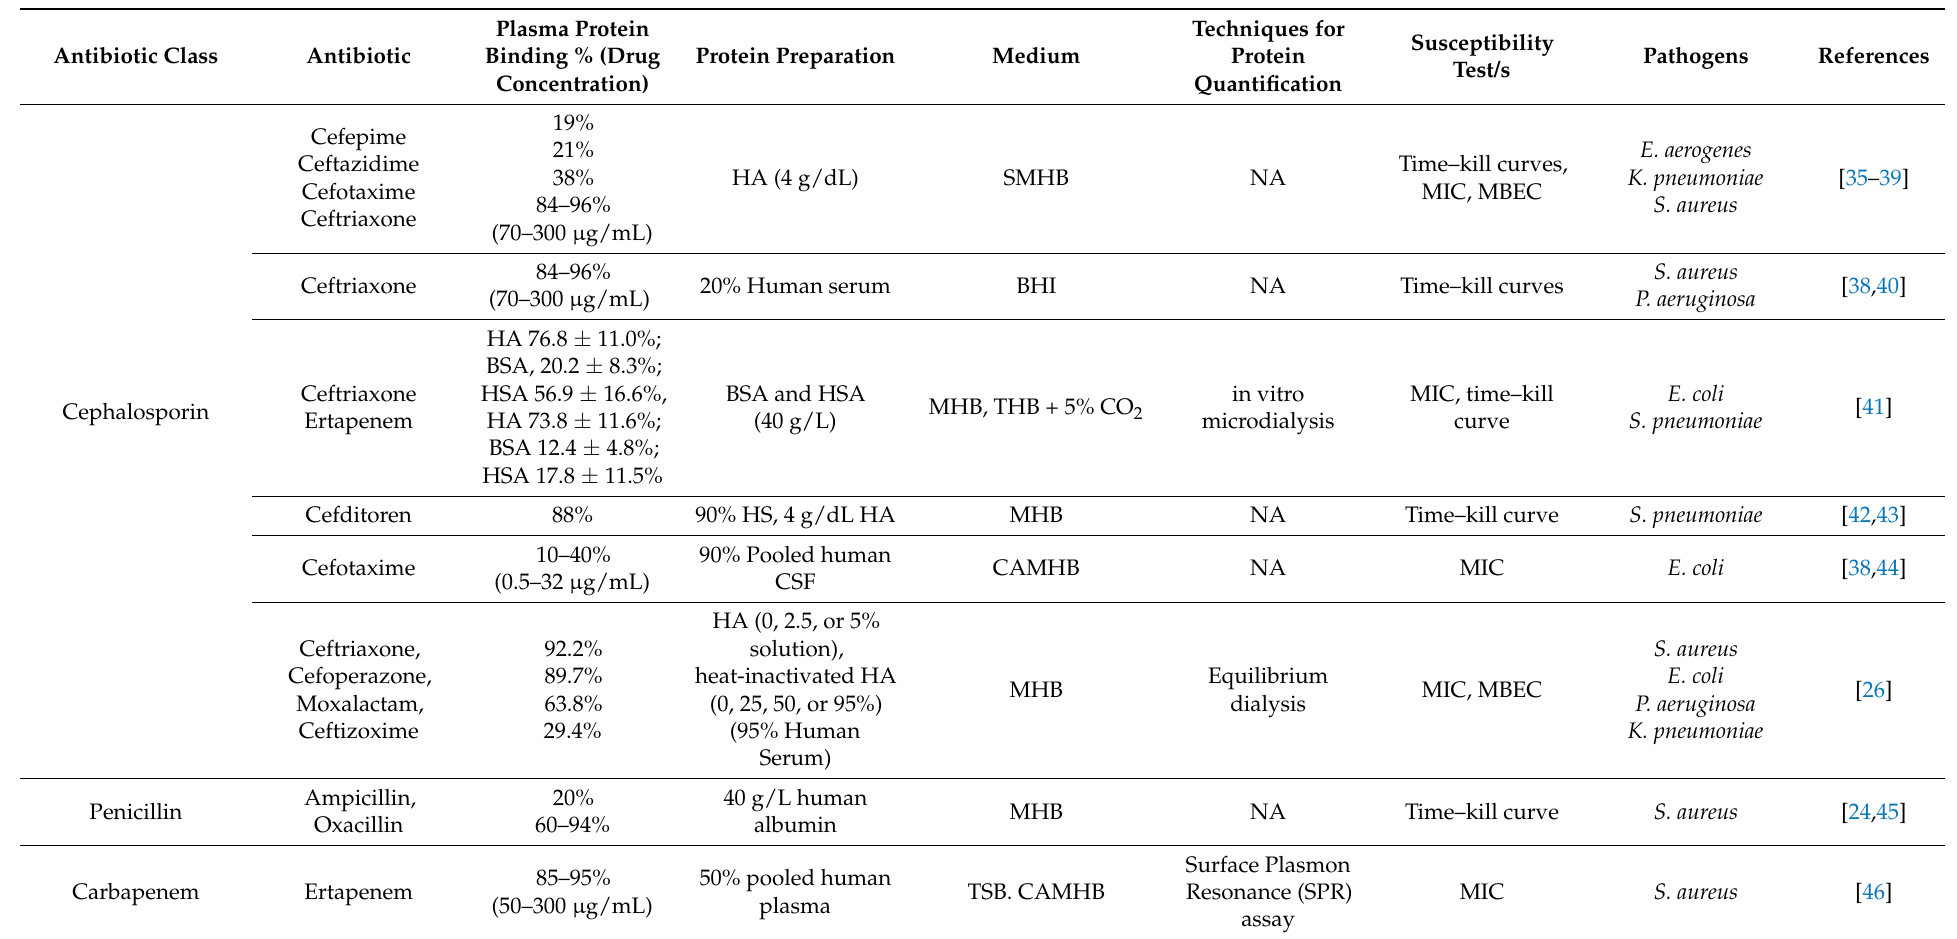
Table 1. Examples for studies that assessed the effect of plasma protein binding on antimicrobial